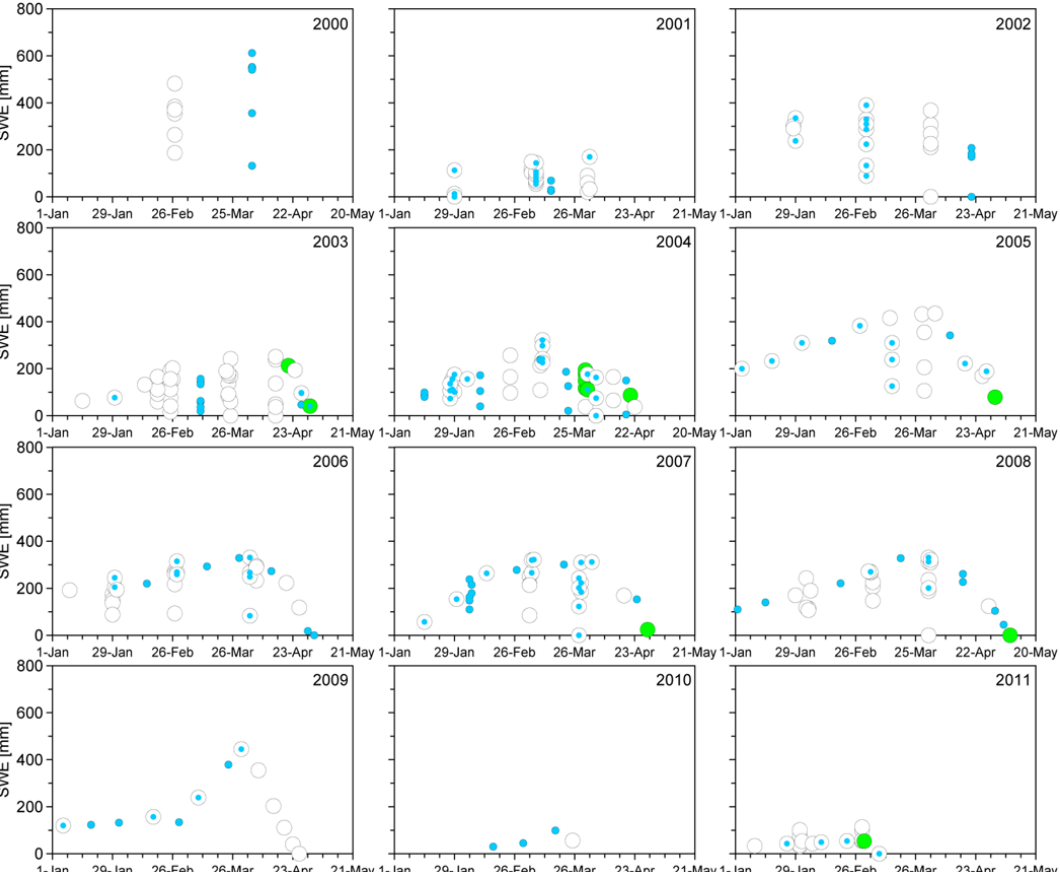
Fig. 6. Snow water equivalent (SWE) observations at forest sites and MODIS classification at the respective pixels in individual snow seasons (2000–2011). Colors indicate MODIS snow (white), land (green) and cloud (blue) classifications. Overlapping of smaller (cloud) with larger (snow or land) symbols indicates the information is from the MODIS 2-day filter instead of the original cloud classification by MODIS for that